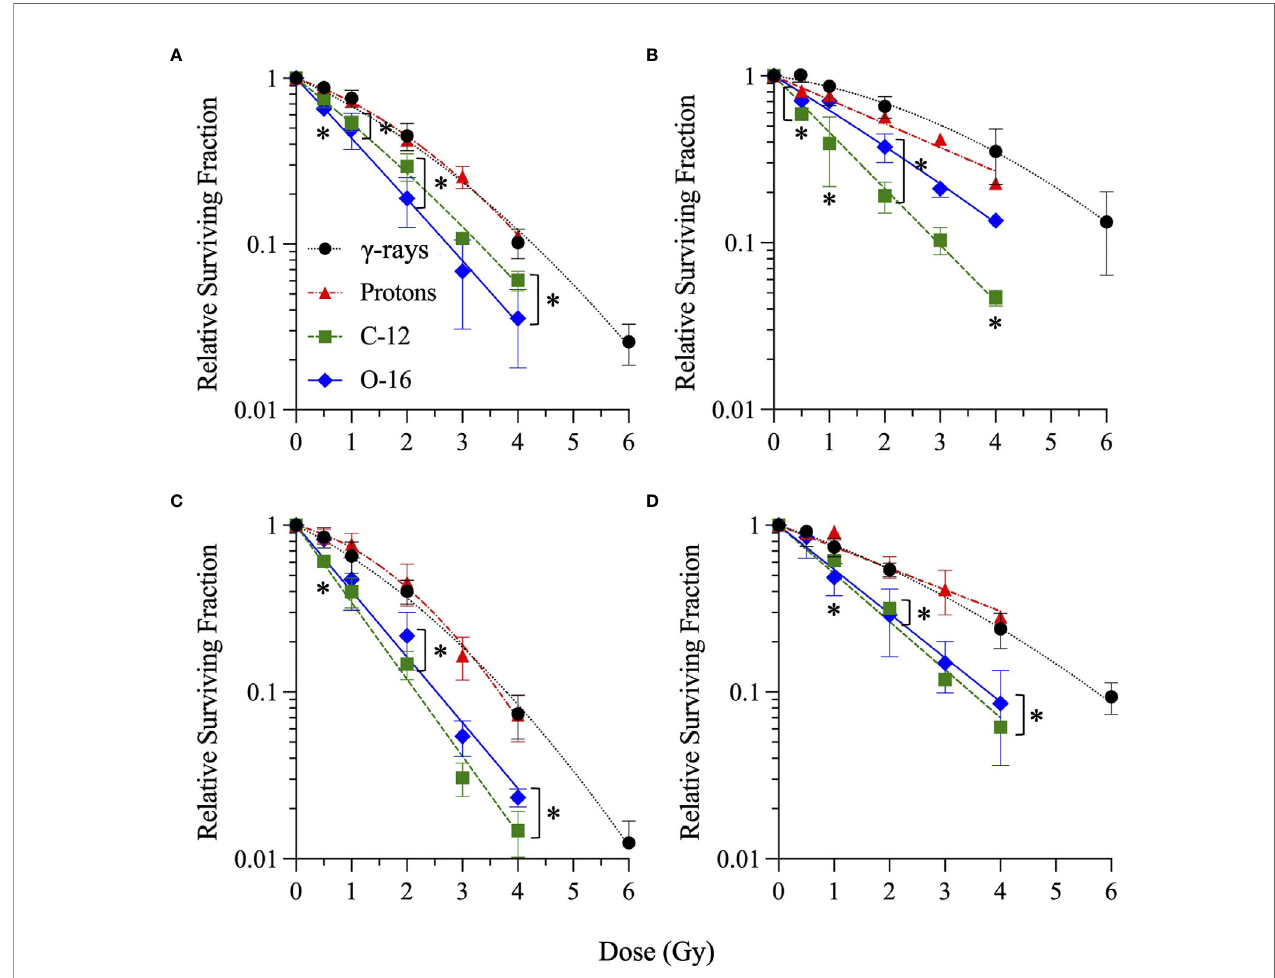
FIGURE 6 | Clonogenic survival of DMSO-treated (vehicle control) G0/G1-phase normal NFF28 primary fi broblasts (A) and asynchronously growing A549 lung carcinoma (B) , U2OS osteosarcoma (C) , and U87MG malignant glioma cells (D) irradiated with cesium-137 g -rays, 200 MeV protons, 290 MeV/n C-12 ions, or 350 MeV/n O-16 ions. Data reported as mean ± SD; where error bars are not visible, they are smaller than the data point. A LET-dependent increase in cell killing is observed for NFF28 fi broblasts; however 290 MeV/n C-12 ions (LET = 13.02 keV/µm) were more effective than 350 MeV/n O-16 ions (LET = 20.90 keV/µm) for cell killing in all three tumor cell lines. Asterisks mark signi fi cant differences compared to cesium-137 g -rays at p -values of ≤ 0.05 (*) by one-way